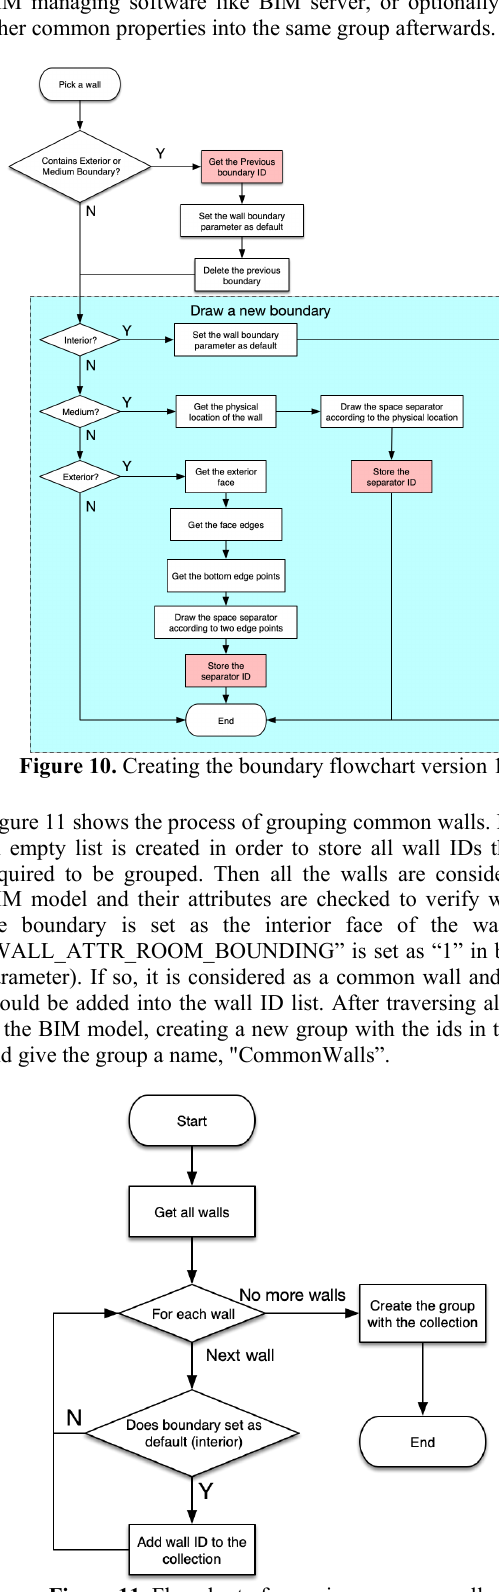
Figure 11. Flowchart of grouping common walls